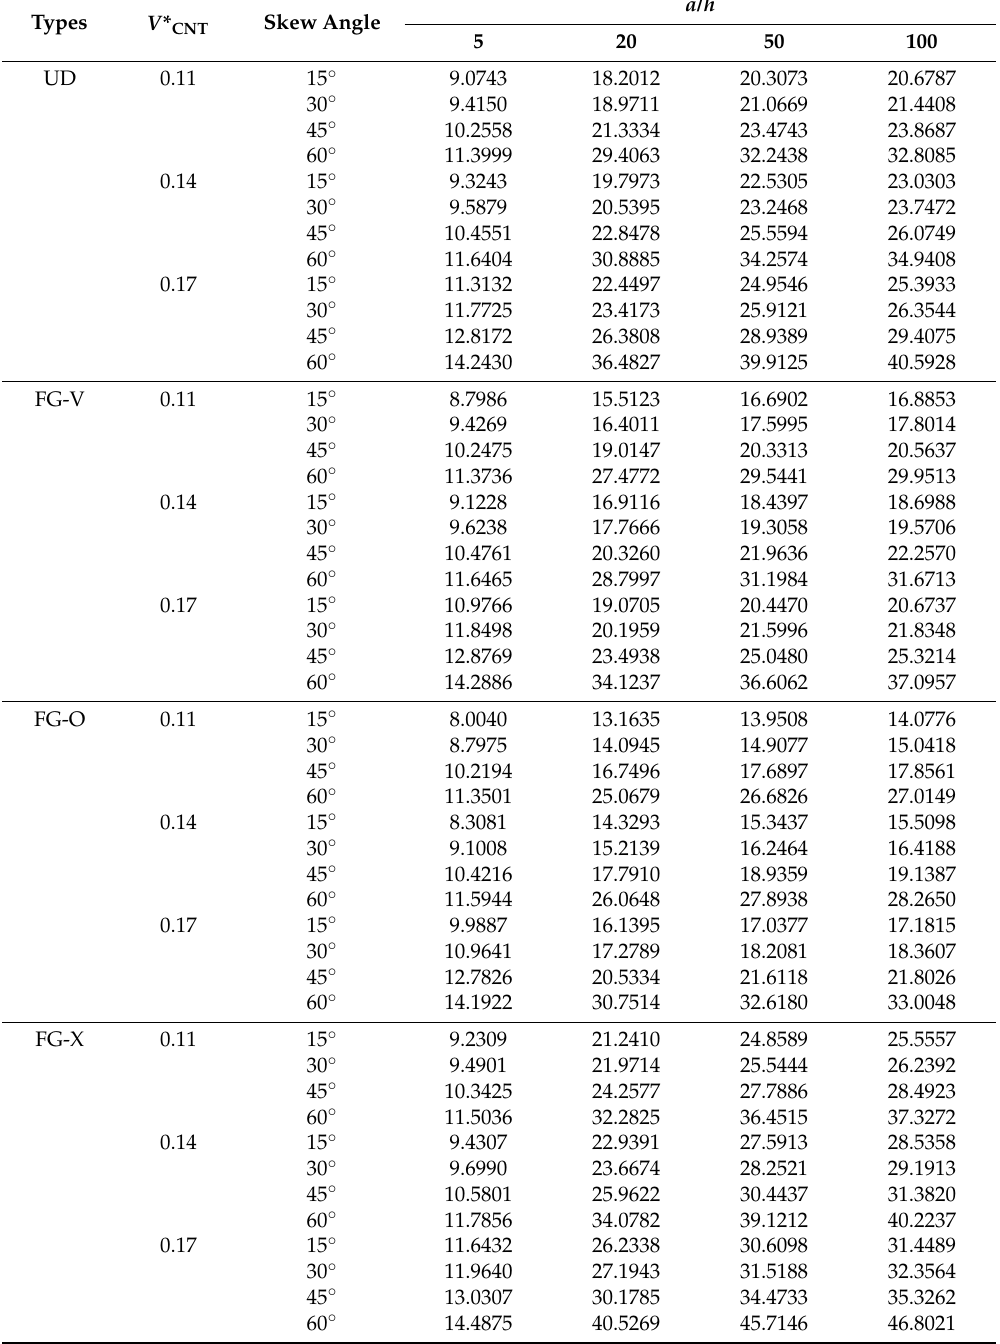
Table 13. Variation of fundamental natural non-dimensional frequency parameters of FG-CNT- reinforced rhombic